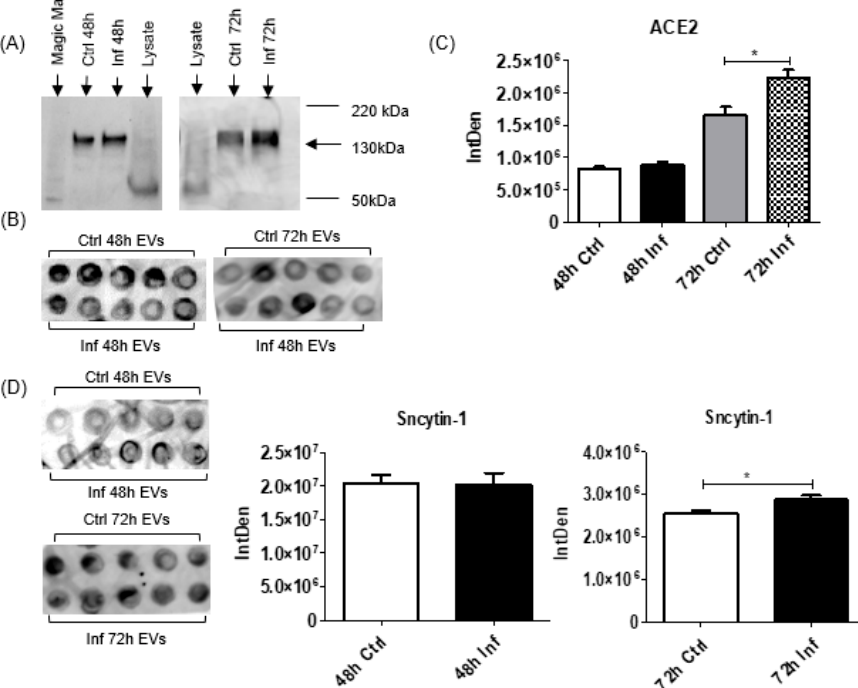
Figure 3. Host receptor and virus-specific protein expression levels after CCoV infection. Schematic ( A ) western blot and ( B ) dot blot showing expression of coronavirus host receptor, angiotensin- converting enzyme (ACE2), at 48 h and 72 h in the control and infection EVs; ( C ) graphs showing densitometric analysis of dot blot of ACE2 via Bio-Rad imaging program and GraphPad Version 5 software; ( D ) schematic dot blot images and densitometric graph for retroviral protein, syncytin-1, via Bio-Rad imaging program and GraphPad Version 5 software in isolated EVs at 48 h and 72 h. Statistical analysis of obtained data points was performed using one-way ANOVA with Tukey post hoc analysis. Statistical significance is indicated by the mean ± SD and is defined as p ≤ 0.05